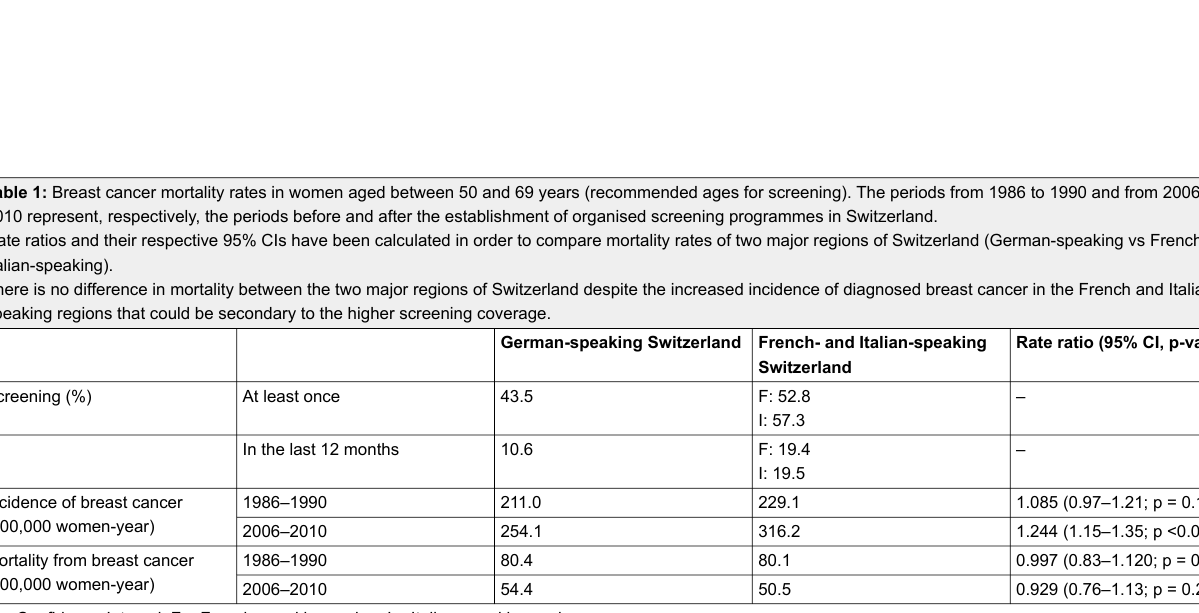
C = Confidence Interval; F = French-speaking region; I = Italian-speaking region Sources: Swiss Federal Statistical Office; National Cancer Programme for Switzerland 2011–2015,